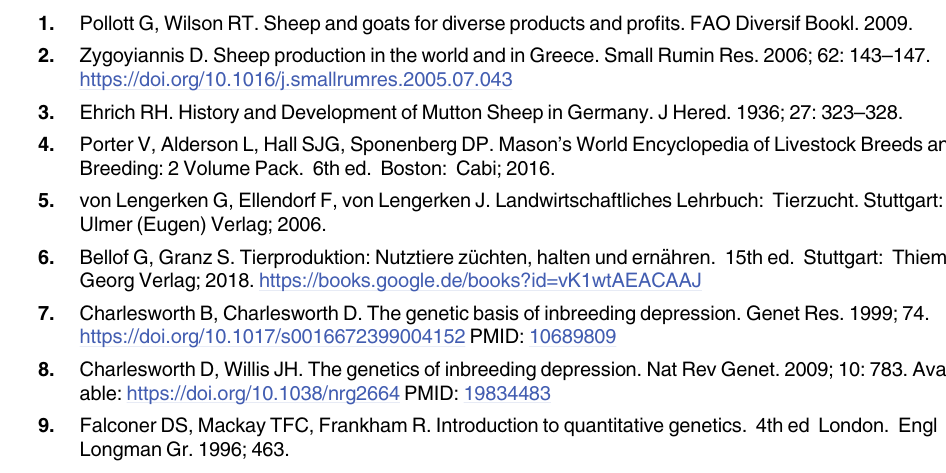
: Left) or to length of chromosome (F : ROH_KA ROH_KK ROH_KA